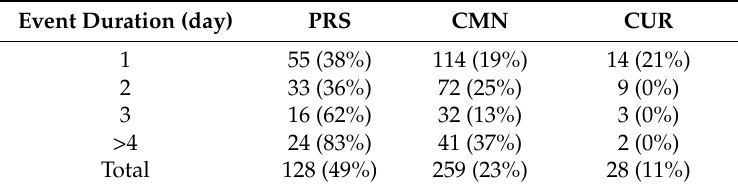
Table 3. Agreement in percentage between in situ SI detection and STEFLUX outputs as a function of event duration. For each station, the number of in situ SI events are provided, together with the percentage of detection by STEFLUX (within brackets). Event Duration (day)